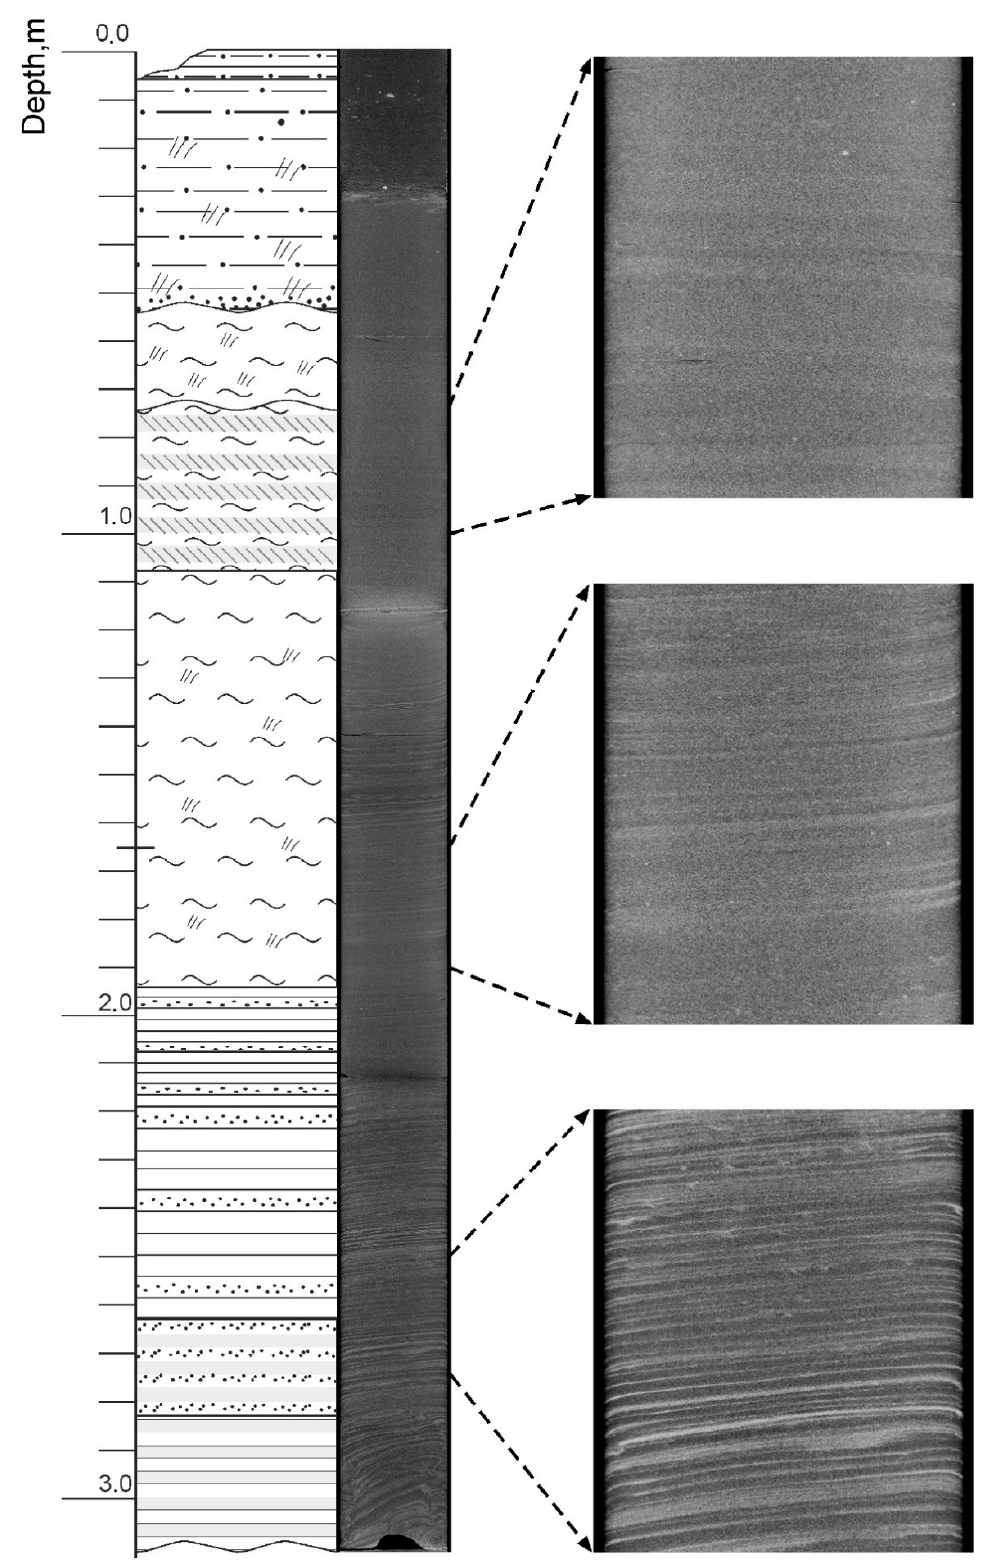
Figure 12. Radiographic contrast cross-section of core ONG-5 and its separate enlarged fragments. The lower part of the column reveals varved clays of the Late Pleistocene period. See Figure 8 for the legend.